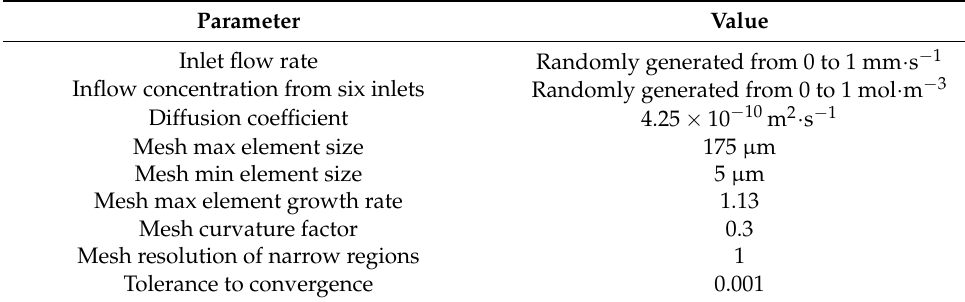
Figure 2. The overall flow of automating COMSOL to prepare the dataset of the proposed gradient generator with different inlet configurations. The linear flow rate of all six inlets varies from 0 mm · s − 1 to 1 mm · s − 1 , and the inflow concentration varies from 0 mol · m − 3 to 1 mol · m − 3 . Table 2. Simulation parameters in